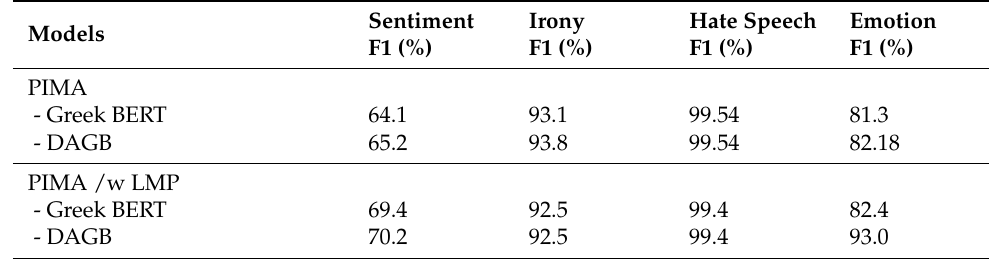
Table 7. Proposed model experimental